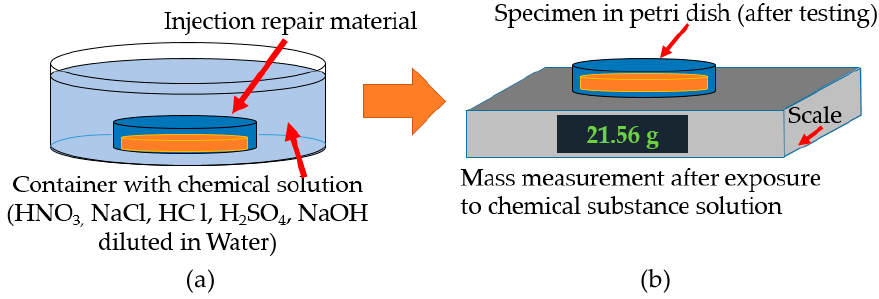
Figure 8. The test method apparatus: ( a ) exposure to the chemical solution and ( b ) the mass measurement after